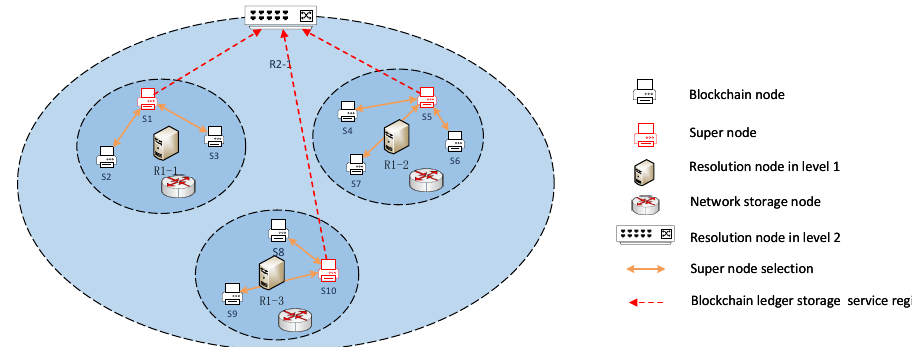
Figure 5. Supernode